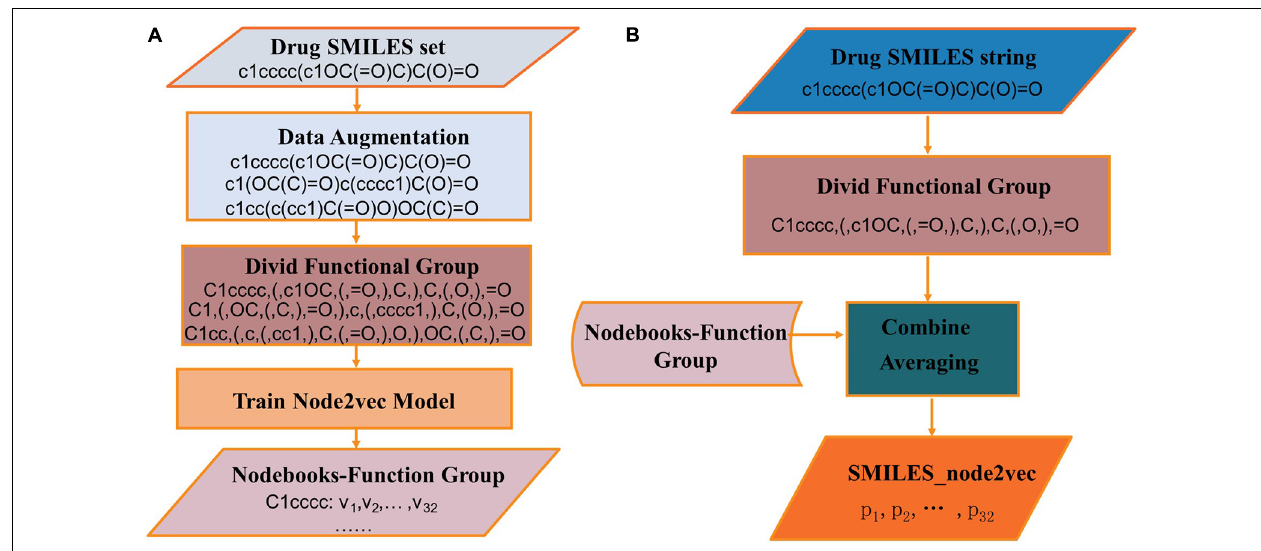
FIGURE 6 | The processes of (A) constructing Wordbooks-Orig and (B) generating SMILES_node2vec.